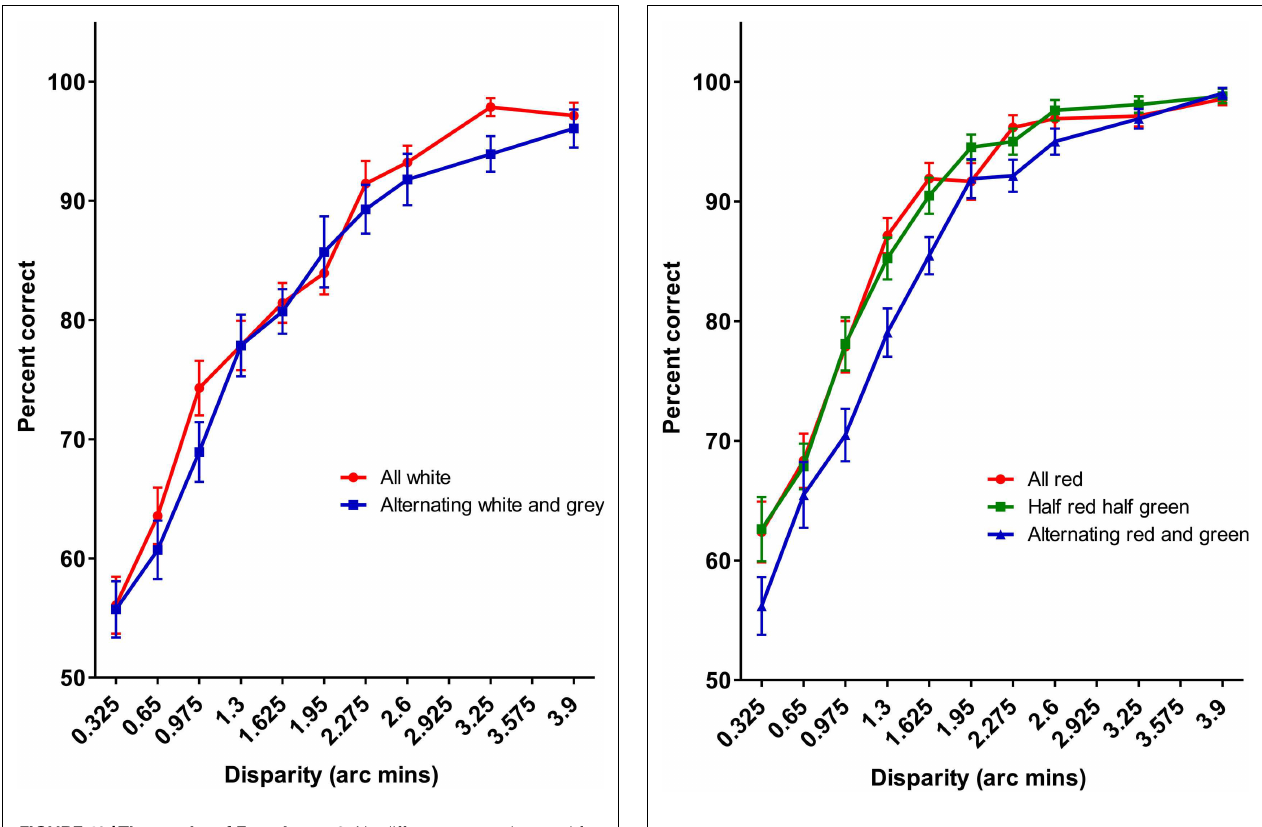
FIGURE 11 |The results of Experiment 4. As with Experiment 1, it was significantly harder detecting disparity increments in the alternating red-green display than either the uniformly red or half-red/half-green